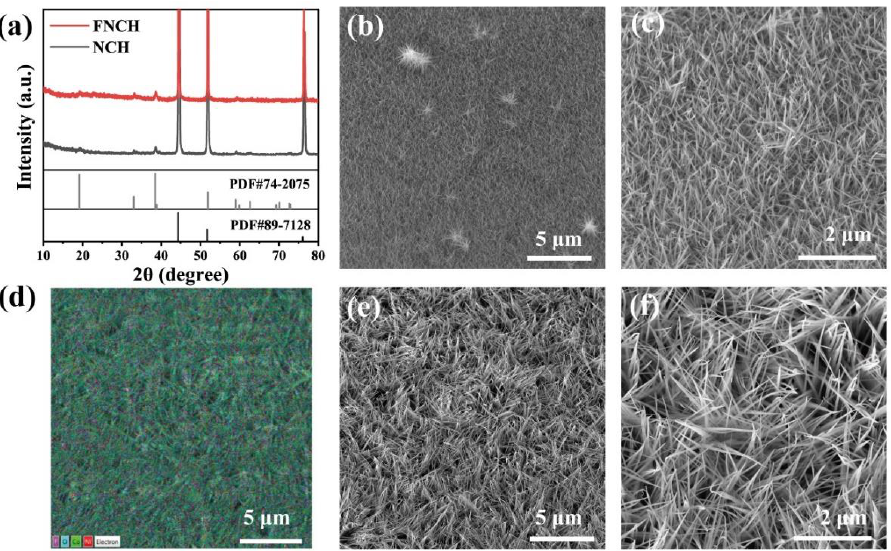
Figure 1. Characterization of phase and morphology. ( a ) XRD pattern of FNCH and NCH; ( b , c ) SEM images of NCH; ( d ) SEM EDX mapping of FNCH; ( e , f ) SEM images of FNCH.